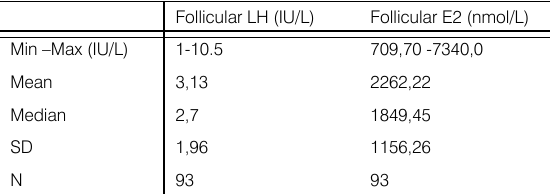
Table 2. Follicular fluid LH and